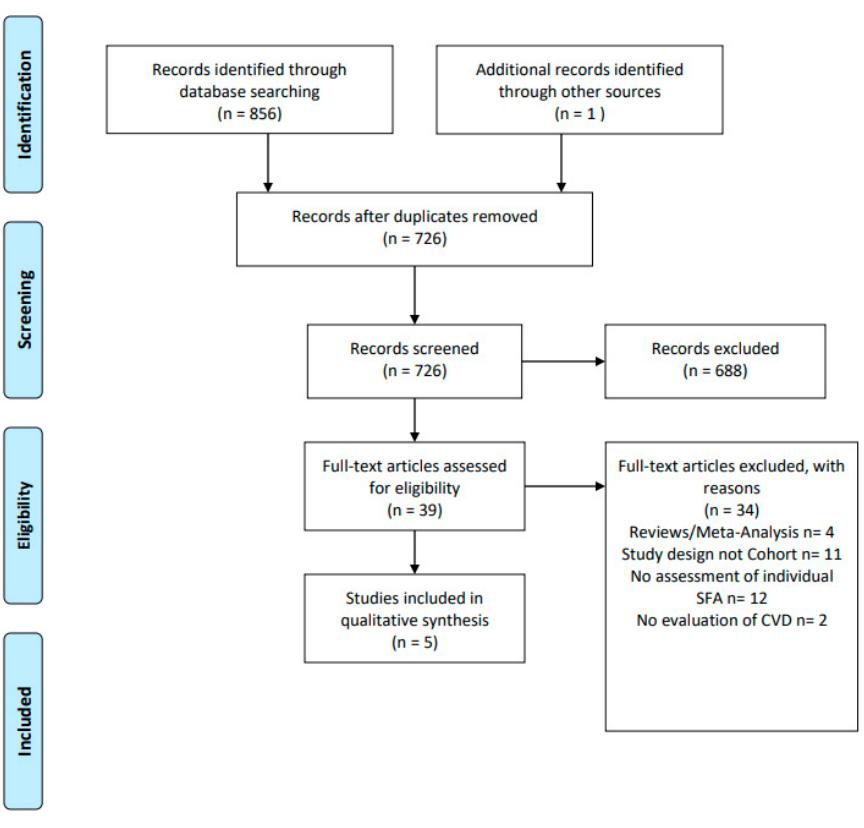
Figure 1. PRISMA 2022 flow diagram.